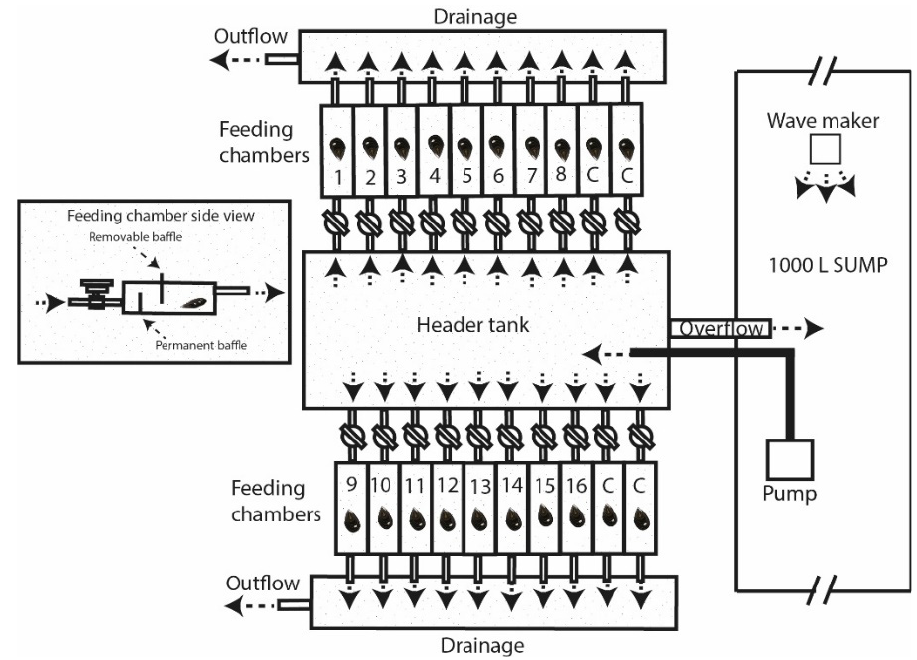
Figure 2. Diagram of the apparatus used to measure the filter-feeding behavior of Mytilus gallopro- vincialis using water collected from the Swan-Canning Estuary. ‘C’ denotes control mussels (empty shells). Arrows denote the direction of water flow.